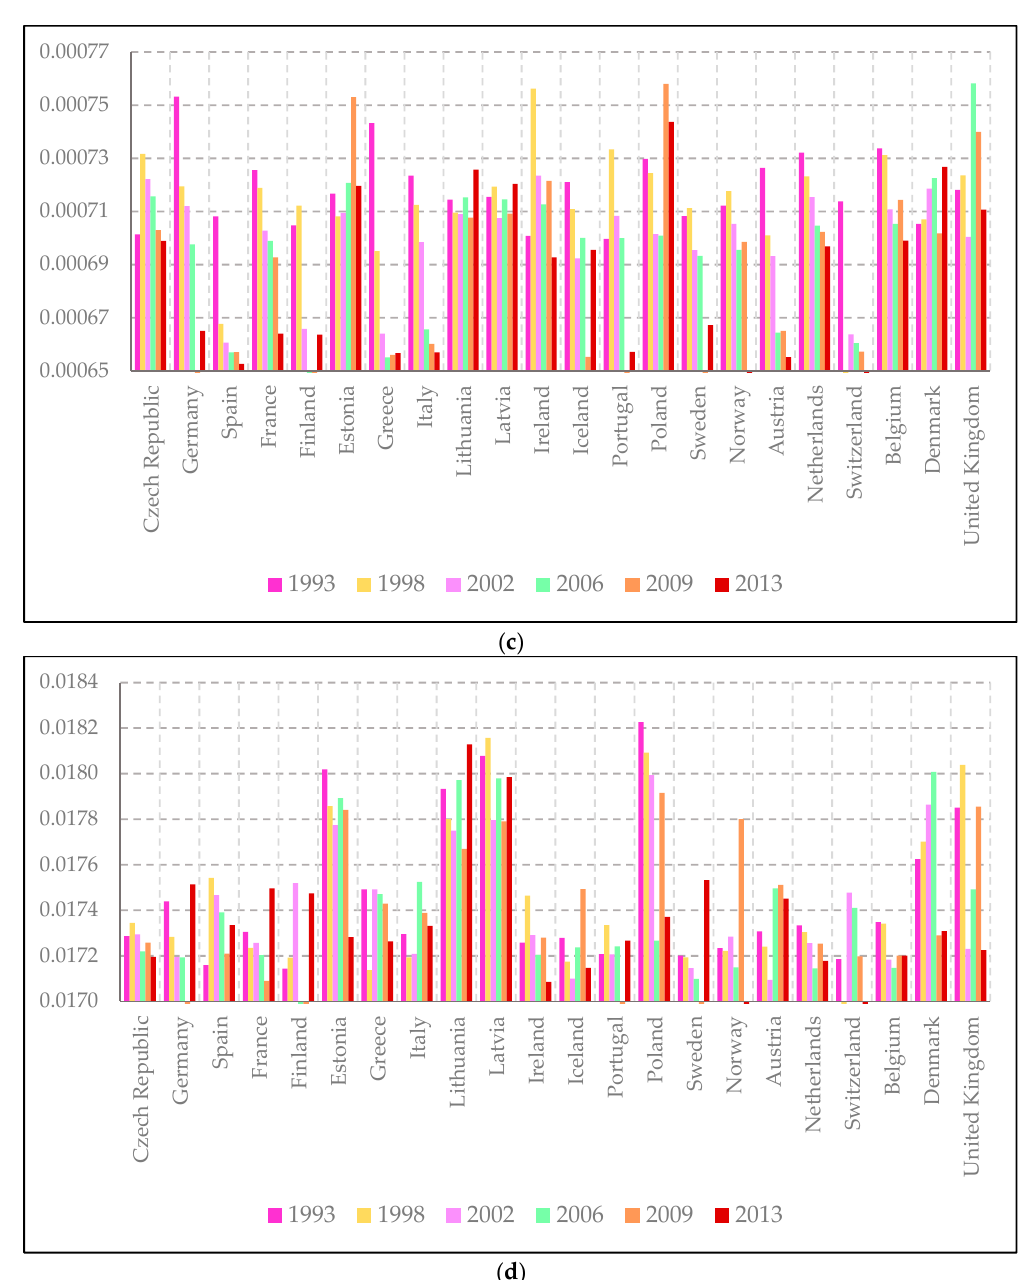
Figure 3. Parameter values estimated for female gender in selected years of period 1993–2013: ( a ) Infant mortality (parameter θ ); ( b ) Population aging (parameter ξ ); ( c ) Individual unexpected mortality (parameter κ ); ( d ) Population mortality due to hazardous events (parameter λ ).